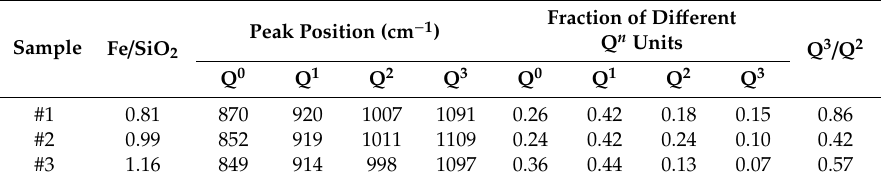
Table3. FTIRpeakshiftsandareafractionsfromFTIRspectraofFCSMslagswithdi ff erentFe / SiO 2